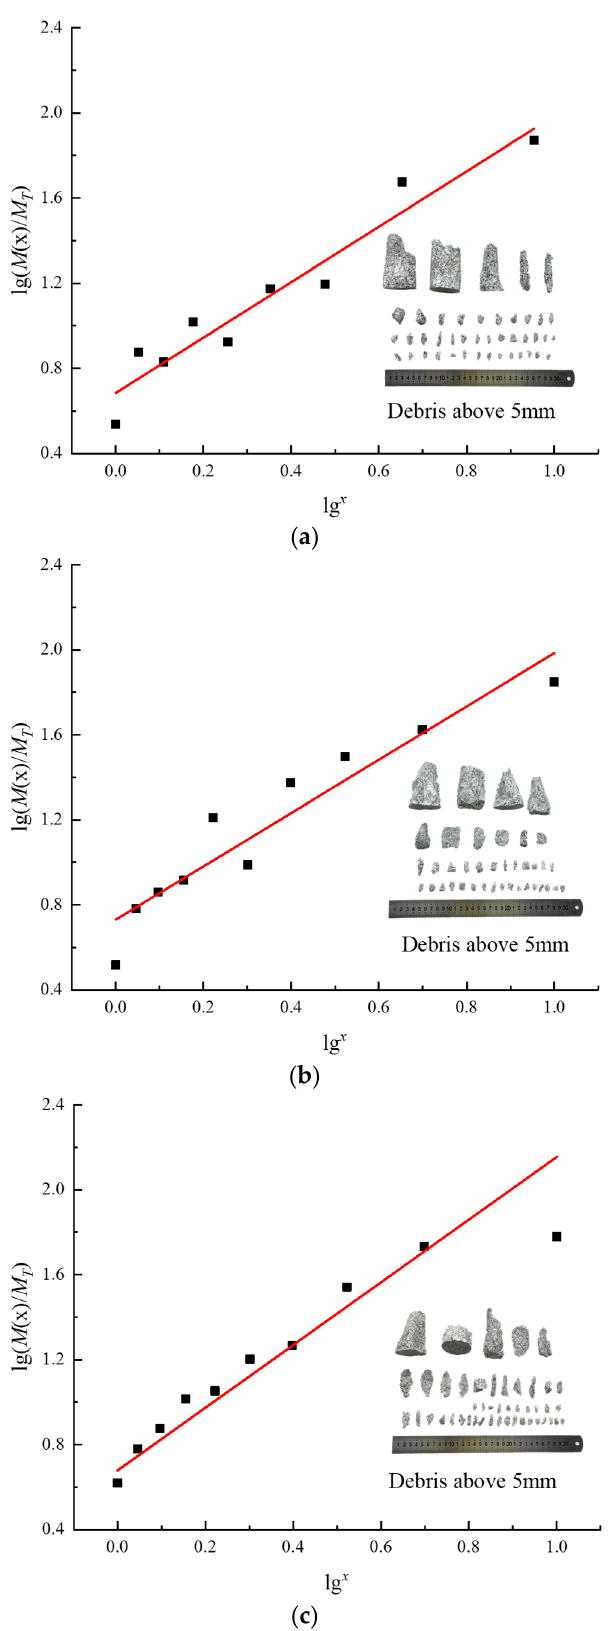
Figure 13. The log( M ( x )/ M T )–logx lines of rocks under 60% of the UCS: ( a ) 20 MPa; ( b ) 30 MPa; ( c ) 40 MPa.